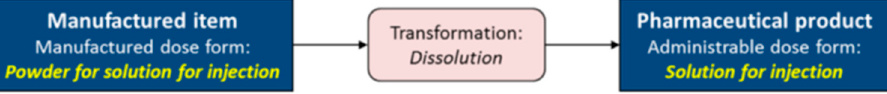
Figure 2. Relationship between manufactured item and pharmaceutical product, and the use of pharmaceutical dose forms as the manufactured dose form.